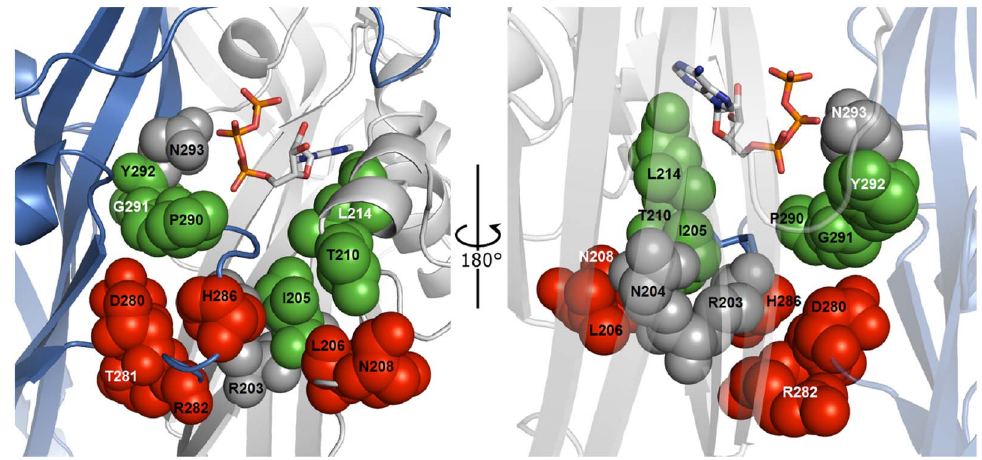
Figure 6. The structure of the ATP binding site in a rP2X4R homology model. Two panels show the position of affected residues (rotated 180 u ) at the interface between the LF and DF domains. The low-response residues without defined EC 50 values are grey spheres. The amino acid residues presented as green spheres demonstrate the topology of mutants with changes in ATP potency and/or efficacy (EC 50 and I max ), and agonist profile ( Group I from Table 2). The amino acids presented in red spheres illustrate the position of residues whose mutation has affected ATP potency and/or efficacy without changing the action of ATP analogs ( Group II from Table 2). In both panels, the ATP molecule is situated between two adjacent P2X4R subunits (blue and gray). The ATP molecule is shown in a wireframe model.